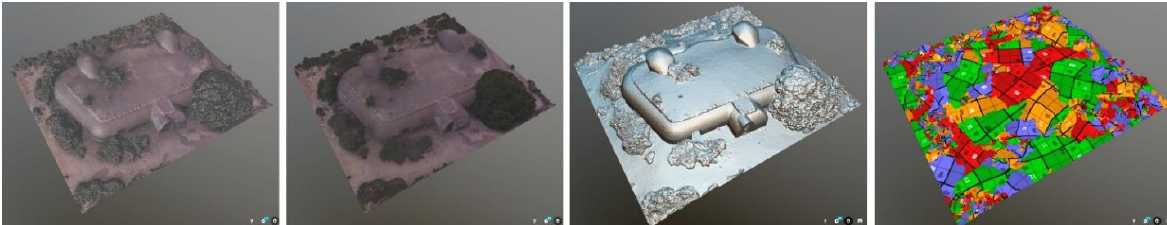
Figure 11. Frames of digital photogrammetric models, from left to right: rendering, texturing, metallizing and UV mapping. Extracted from the public repository where two models have been uploaded: https://skfb.ly/6KSBI y